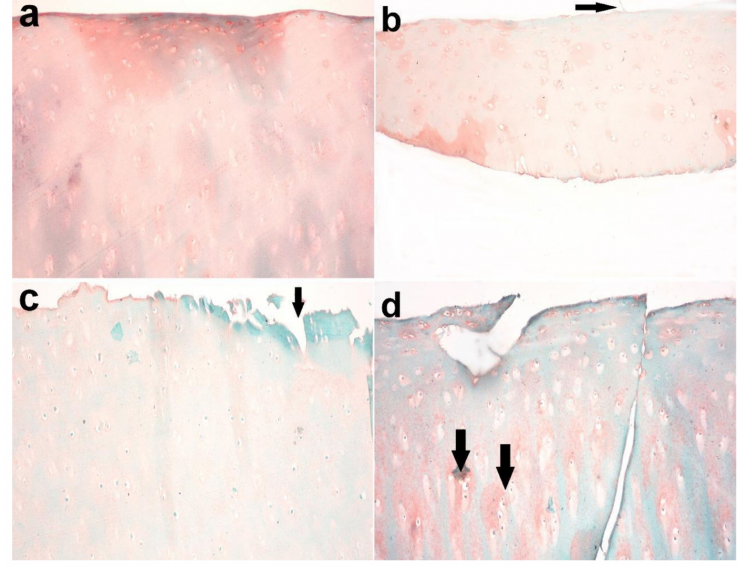
Figure 9. Articular cartilage of donkey. ( a ) Normal histology of articular cartilage with normally distributed chondrocytes and a smooth surface in the control group (right radius articular cartilage). ( b ) Superficial fibrillation and decreased or variable staining intensity at the surface in the MIA-injected group after 3 months (arrow). ( c ) Uneven surface and matrix fibrillation became clearer and extended vertically down into the mid-zone with the loss of proteoglycans and loss of viable chondrocytes in the treated group (arrow) after 5 months. ( d ) The fissures became more extensive and extended into the deep zone, together with further loss of proteoglycan staining and excavation after 7 months. Note the presence of clusters of chondrocyte proliferation (arrow). Safranin O stain X